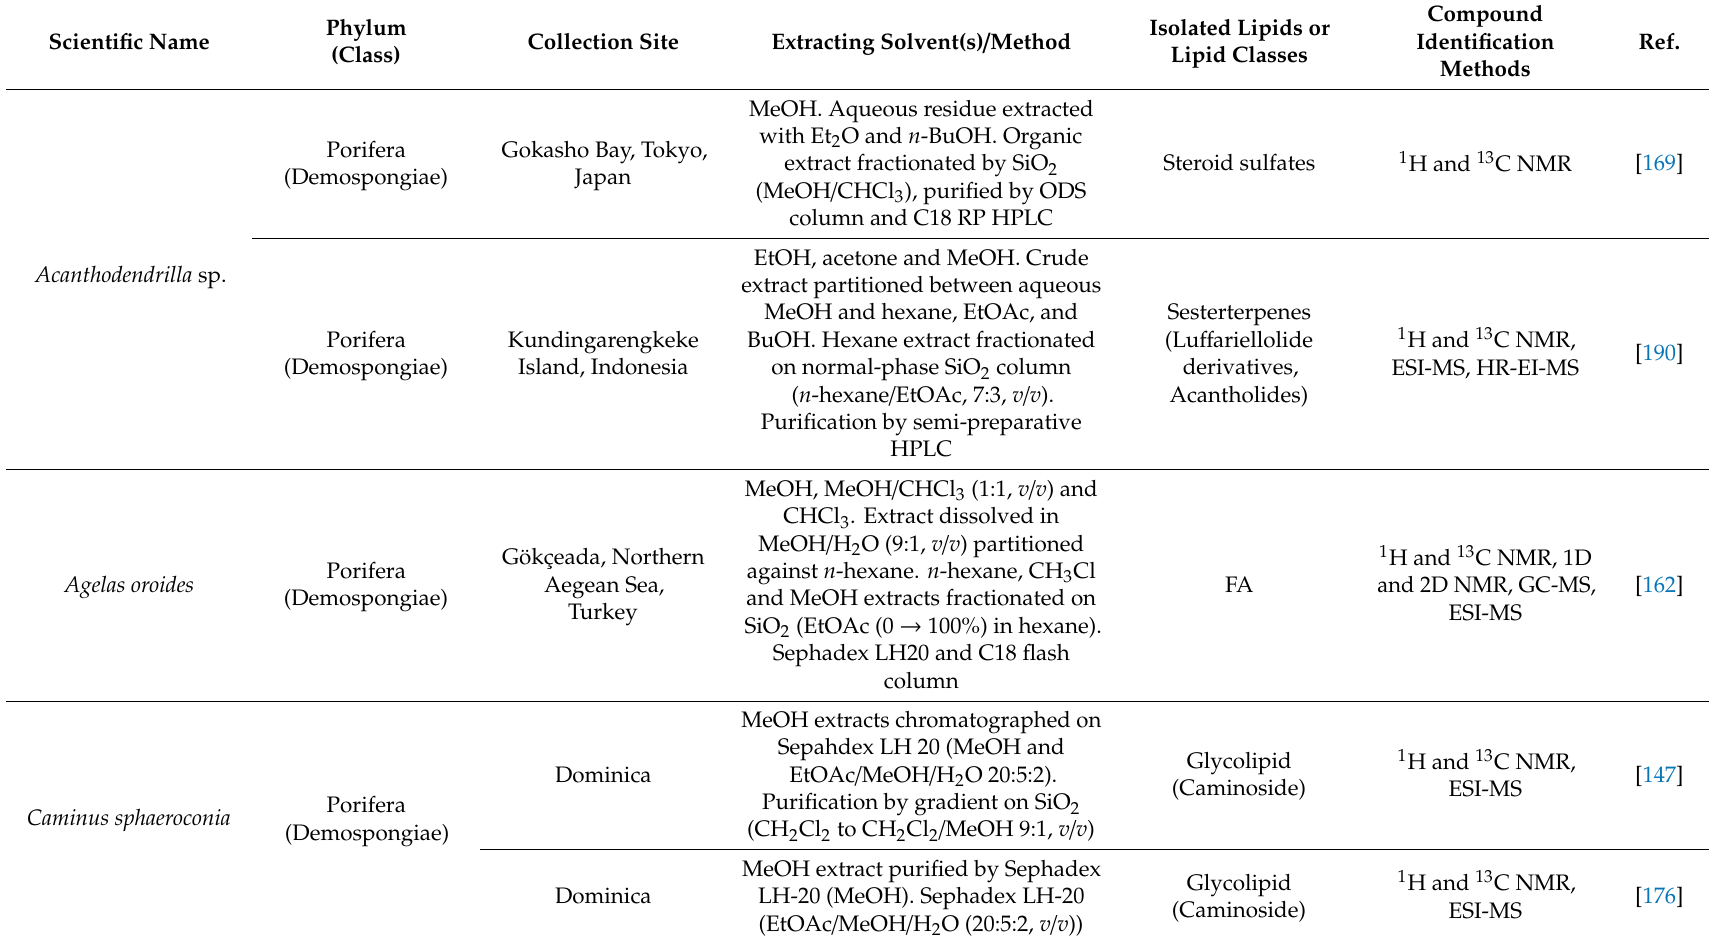
Table 5. Marine invertebrate lipids or lipid-rich extracts with antimicrobial potential, their origin and extraction